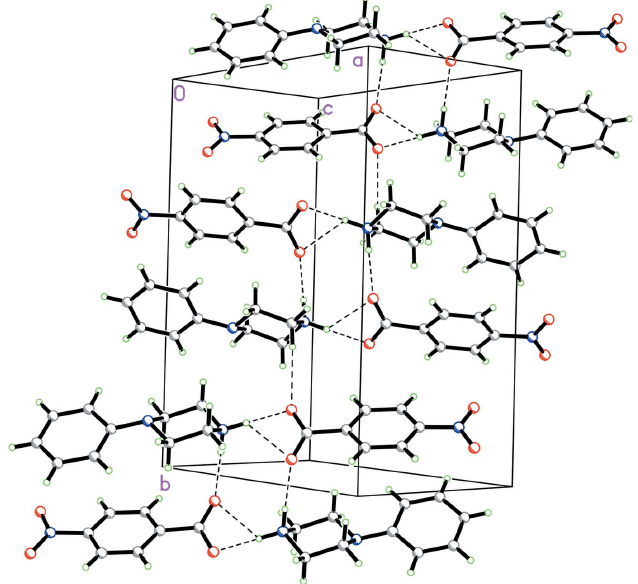
Figure 14 Partial packing diagram for 4 showing the R 8 analogous to the seam of a tennis ball involving N—H (cid:2)(cid:2)(cid:2) O hydrogen bonds.